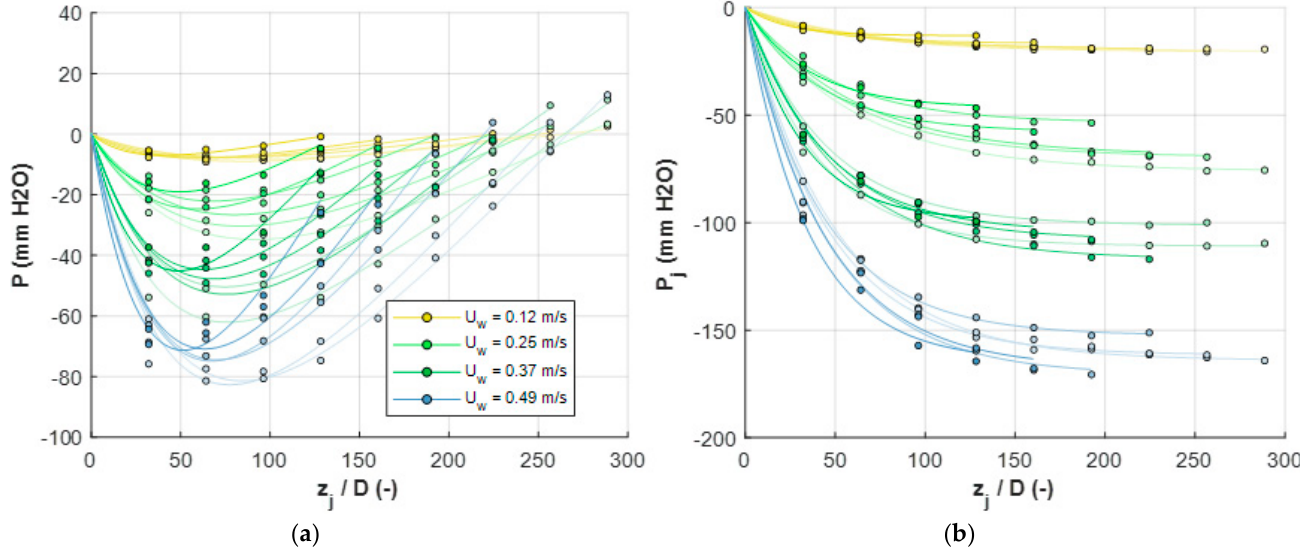
Figure 5. Analysis of Rig ‘B’ dataset. ( a ) Pressure loss P versus normalized distance z j /D. ( b ) Junction pressure loss component P j versus normalized distance z j /D. Table 1. Derivation of the Φ d , k 1 and k 2 parameters within Equation (7).